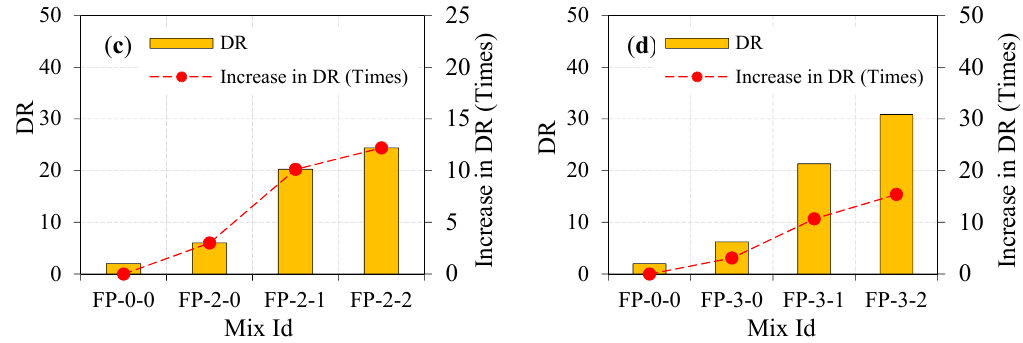
Figure 11. Impact ductility of ferrocement panel under impact load. ( a ) zero layer mesh; ( b ) one layer mesh; ( c ) two layer mesh and ( d ) three layer mesh